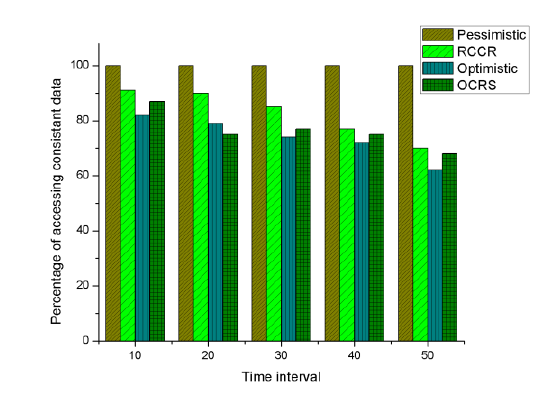
Figure 3. Percentage of accessing consistent data